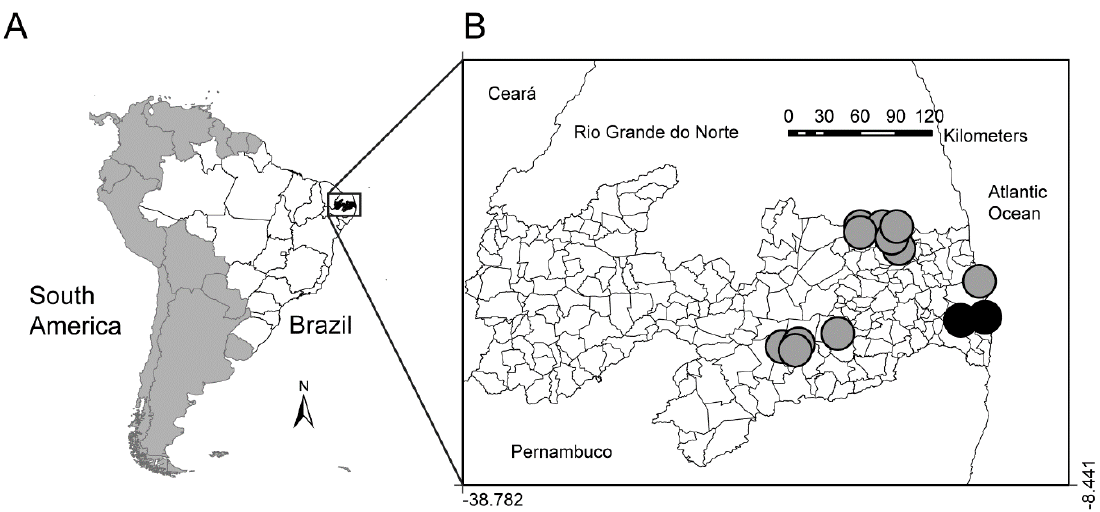
Figure 1. Geographical location of sampled specimens of odonates. ( A ) Map of South America (dark grey) highlighting the geopolitical division of Brazil (white); ( B ) municipality division of Paraíba with the locality of our two sampling sites (black dots) and the other localities for specimens obtained in DSEC/UFPB (grey dots).